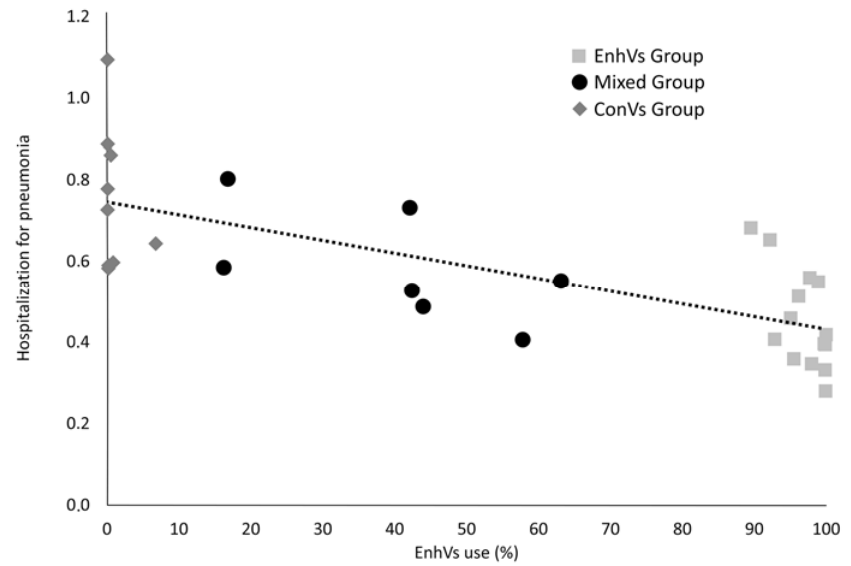
Figure 2. Relationship between level of enhanced vaccine use (%) and hospital admission rate (%) for pneumonia by health district and flu season. The line represents the linear regression equation. The correlation coefficient ( R ) was 0.7235 with a p < 0.001. Table 2. Distribution of the characteristics of the sample by need for hospital admission for pneumonia.